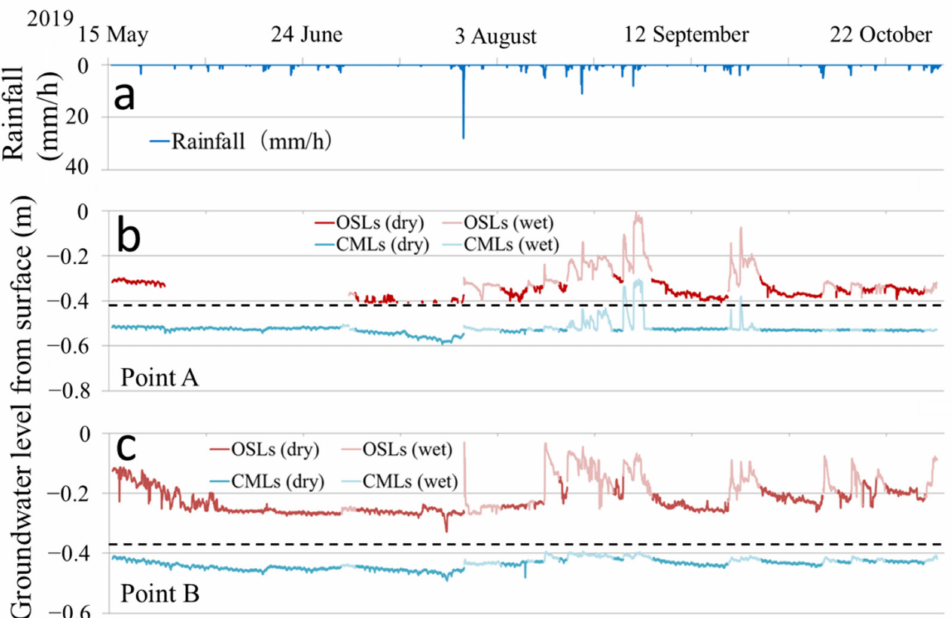
Figure 6. ( a ) Rainfall and groundwater levels at ( b ) Point A and ( c ) Point B. The groundwater level is presented as depth below the ground surface. Dashed lines in panels ( b , c ) indicate the boundary between the OSLs and